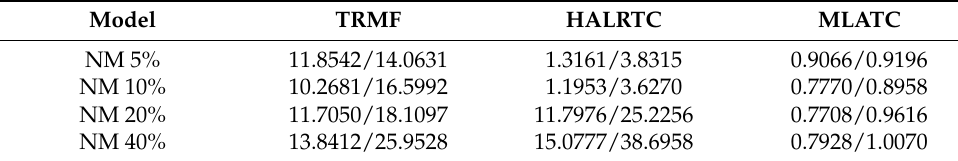
Table 1. Evaluation metrics for data completion in the NM case